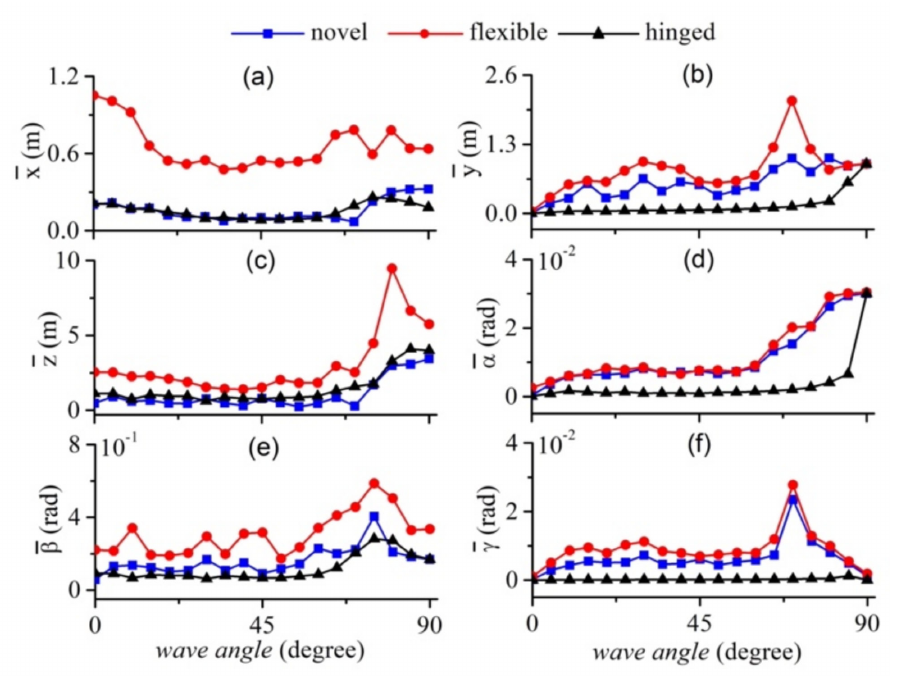
Figure 9. The mean responses of a five–module floating structure in the ( a ) surge, ( b ) sway, ( c ) heave, ( d ) roll, ( e ) pitch, and ( f ) yaw motions for different wave incident